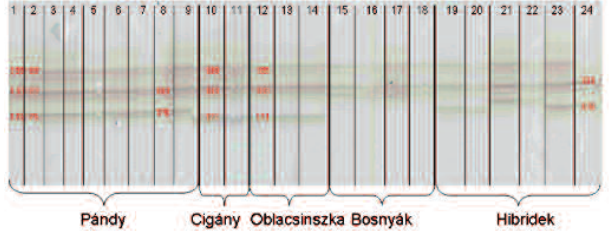
Figure 2. Silver stained microsatellite DNA profiles of the 24 investigated Hungarian sour cherry cultivars with primer pair pchmgms